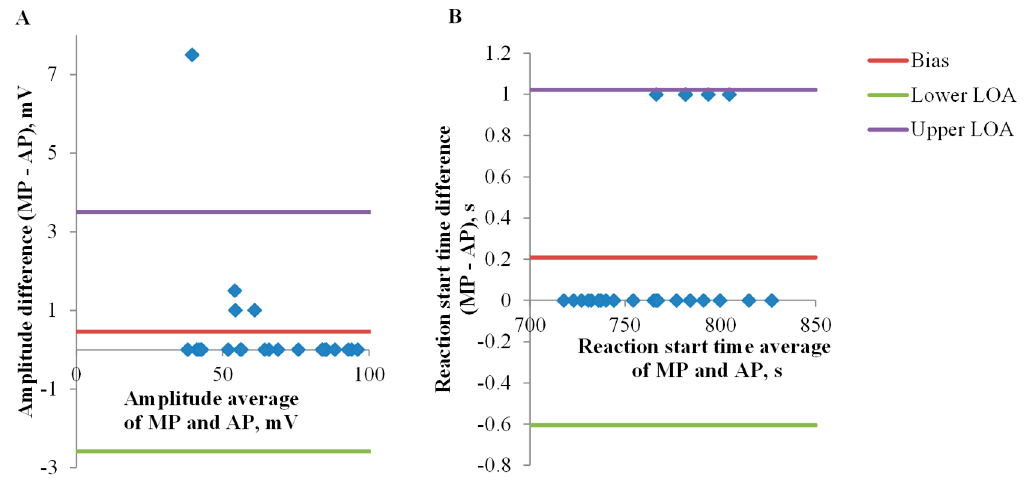
Figure 4. Bland–Altman plot of di ff erences between values of variation potential amplitude ( A ) and reaction start time ( B ) in pea seedlings determined by manual (MP) and automatic (AP) processing. Gauss-2 basis function and scale 5 were used for continuous wavelet transform (CWT). The averaged values of the MP and AP determined parameters are plotted on the X-axis; the di ff erences between the values obtained by MP and AP are plotted on the Y-axis. Bias is the average of the deviations between manual and machine processing. LOAs are limits of agreement, within which 95% of the di ff erences between MP and AP measurement are included.